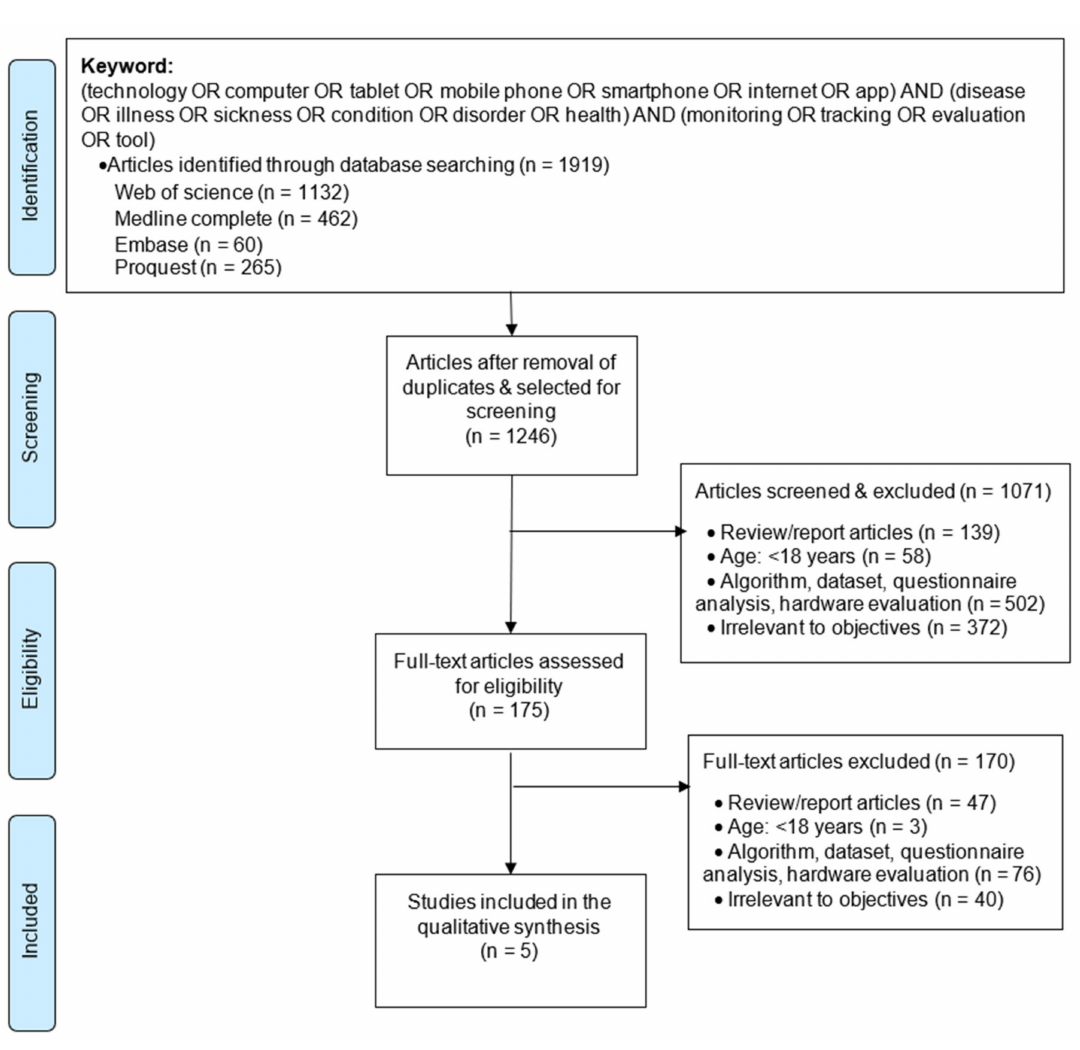
Figure 1. Flow diagram for selection of articles; (adapted from reference